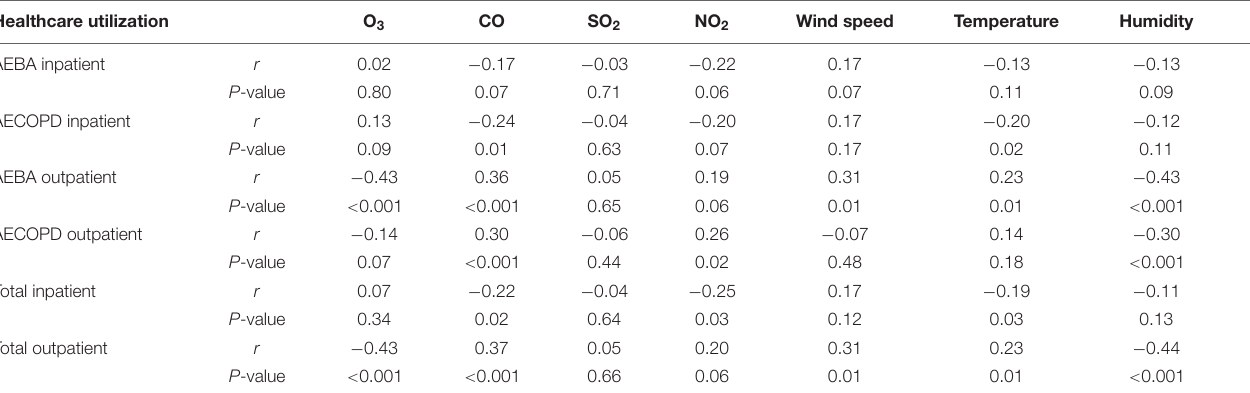
TABLE 4 | Correlations between healthcare utilization and other pollutants and ecological factors. Healthcare utilization O 3